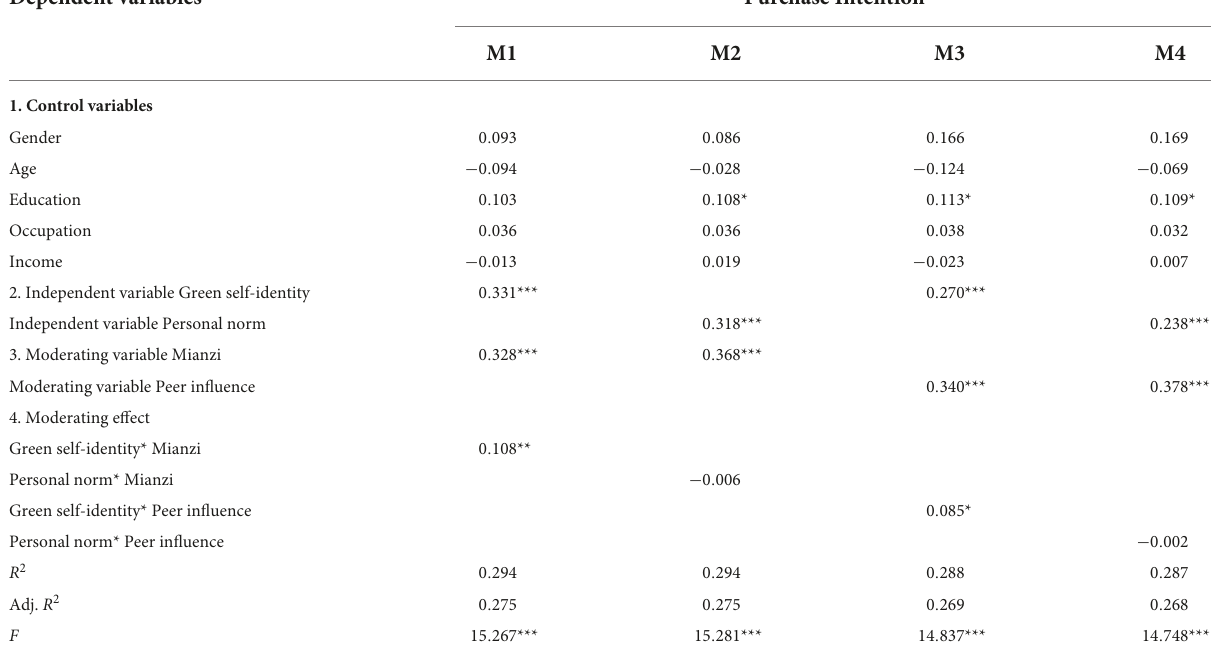
TABLE 4 Hierarchical regression